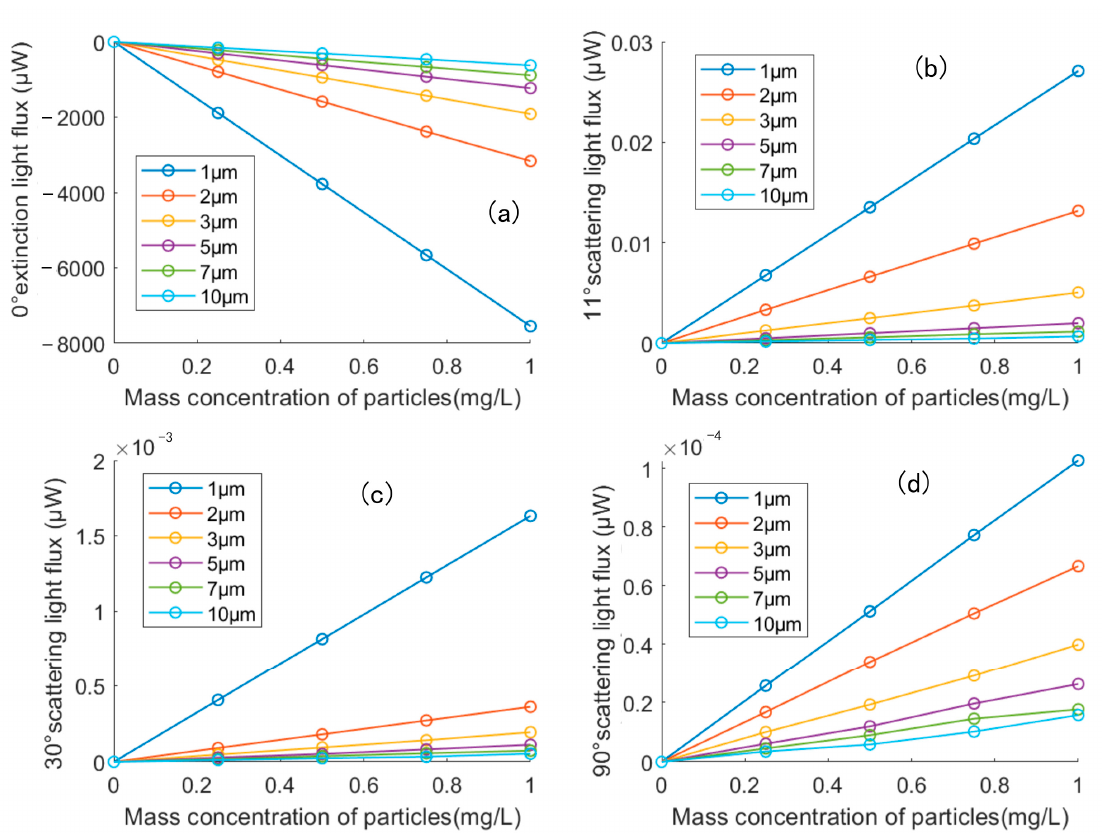
Figure 7. The relationship between the mass concentration of copper particles and the light flux at angle ( a ) 0° ( b ) 11° ( c ) 30° ( d ) 90°. angle ( a ) 0 ◦ ( b ) 11 ◦ ( c ) 30 ◦ ( d ) 90 ◦